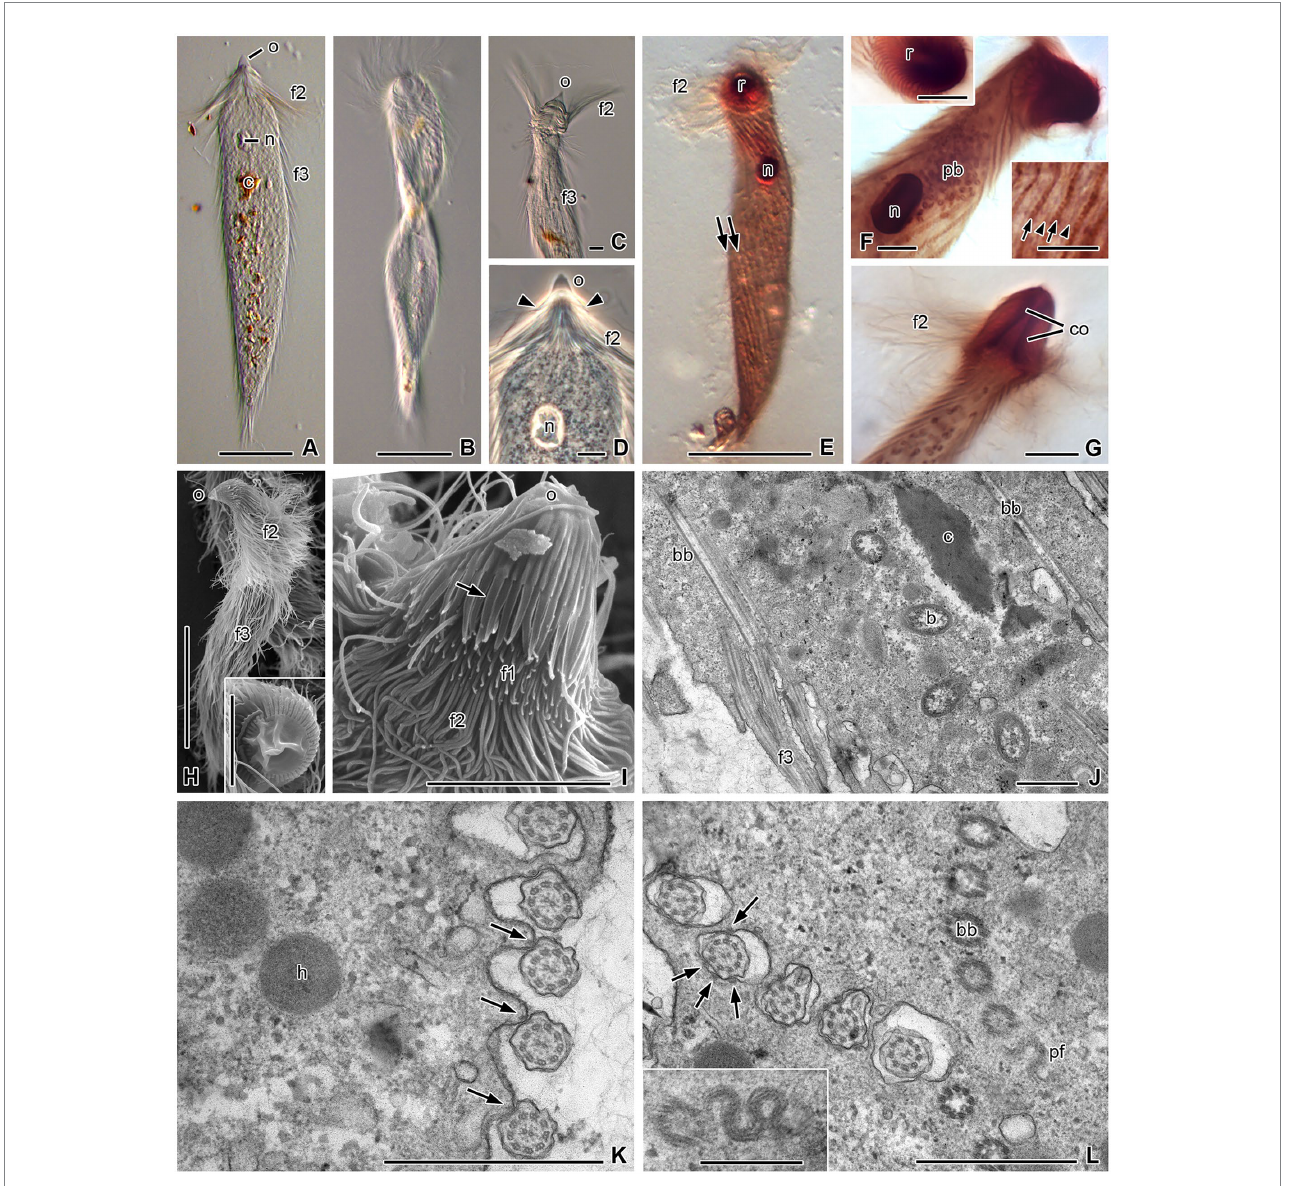
FIGURE 3 Morphology and ultrastructural details of Pseudotrichonympha solitaria . (A) Typical elongated cell with anterior operculum (o), a series of long flagella at the base of the rostrum (f2), and shorter postrostral flagella (f3). Nucleus (n) in anterior third of cell, ingested lignocellulose particles (c) in cytoplasm. (B) Twisted cell in motion. (C) Long rostral flagella struck forward. (D) Anterior third of body; extensions of operculum (arrowheads) are shorter than f3. (E–G) Protargol-staining contrasts nucleus, rows of basal bodies (arrows), parabasal filaments (arrowheads), parabasal bodies (pb), and columella (co) inside rostrum (r). (H) A total cell with pointed operculum and flagella series f2 and f3. Inset: Operculum in top view. (I) Rostrum in side view; apical operculum with numerous slender, leaf-like lappets posteriorly (arrow), which partially cover short series-1 flagella (f1). (J) Longitudinal section through cell periphery; long basal bodies (bb) of f3, cytoplasmic bacteria (b), and ingested lignocellulose particles. (K) Cell periphery in cross-section; flagella attached to cell surface, with electron-dense structures (arrows) supporting attachment sites; hydrogenosomes (h). (L) Basal part of flagella in pouches of the cell surface, with several contact sites to plasma membrane (arrows); inset: sinus-like parabasal filament (pf) under obliquely cross-sectioned rows of basal bodies. (A– G) Light microscopy: (A–C) differential interference contrast, (D) phase contrast, (E–G) protargol staining. (H,I) Scanning electron microscopy. (J–L) Transmission electron microscopy. Scale bars (A,B,E,H) 50 μ m, ( C,D,F,G , insets F,H,I ) 10 μ m, (J–L) 1 μ m, (inset L ) 0.5 μ